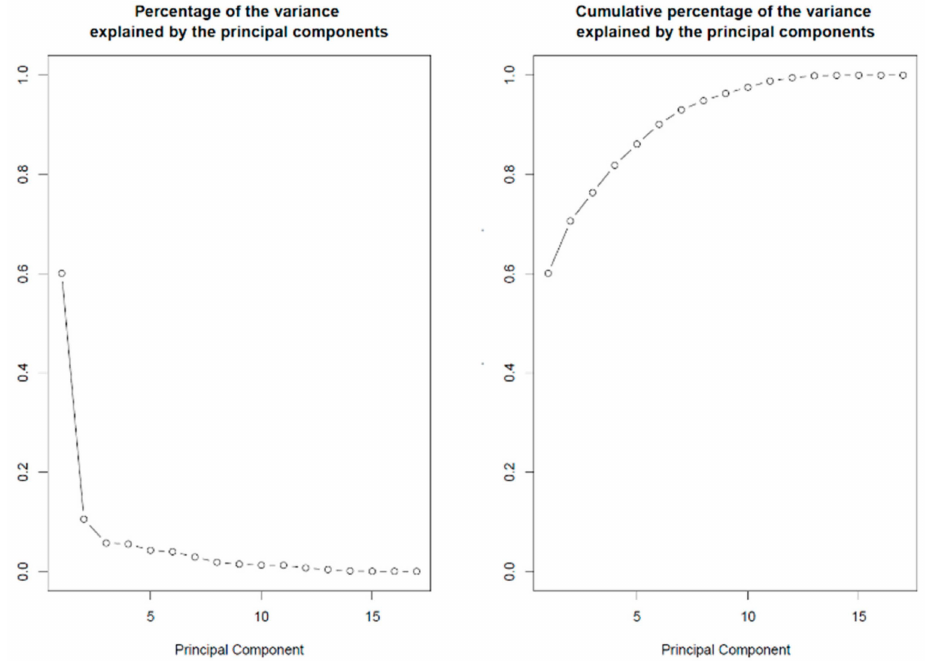
Figure 2. Percentage of variance explained by the PCs. Left panel: The first two components explain 60.08% and 10.53% of the variance, respectively. Right panel: Cumulative percentage of the variance explained. The first two components explain 60.08 + 10.53 = 70.6% of the variance in codon usage between SLRP family members’